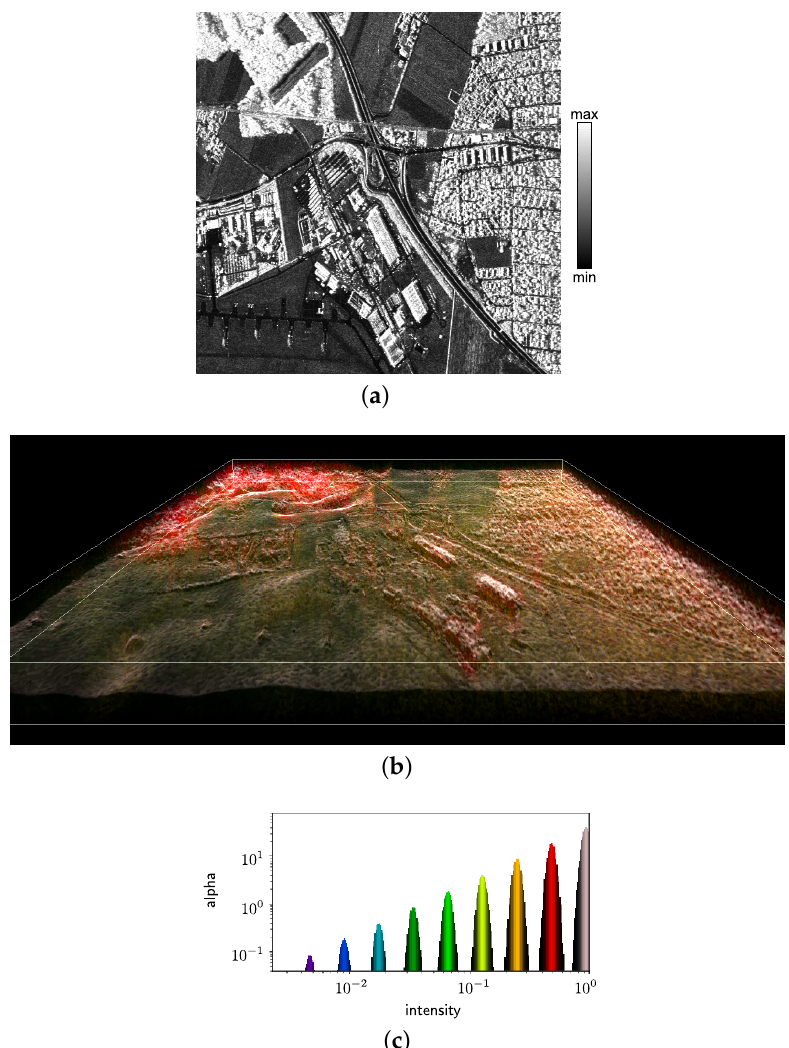
Figure 2. Result of tomographic inversion for multiple pixels. ( a ) Average intensity of an L-band E-SAR (DLR) image stack for a manually cropped area of size 918 × 929 pixels, ( b ) rendering [37] of the 3-D reflectivity image obtained by Capon focusing and ( c ) color scale of this rendered image where alpha is the opacity. Each color and opacity represents a range of intensities. This figure is best seen in the digital version of the